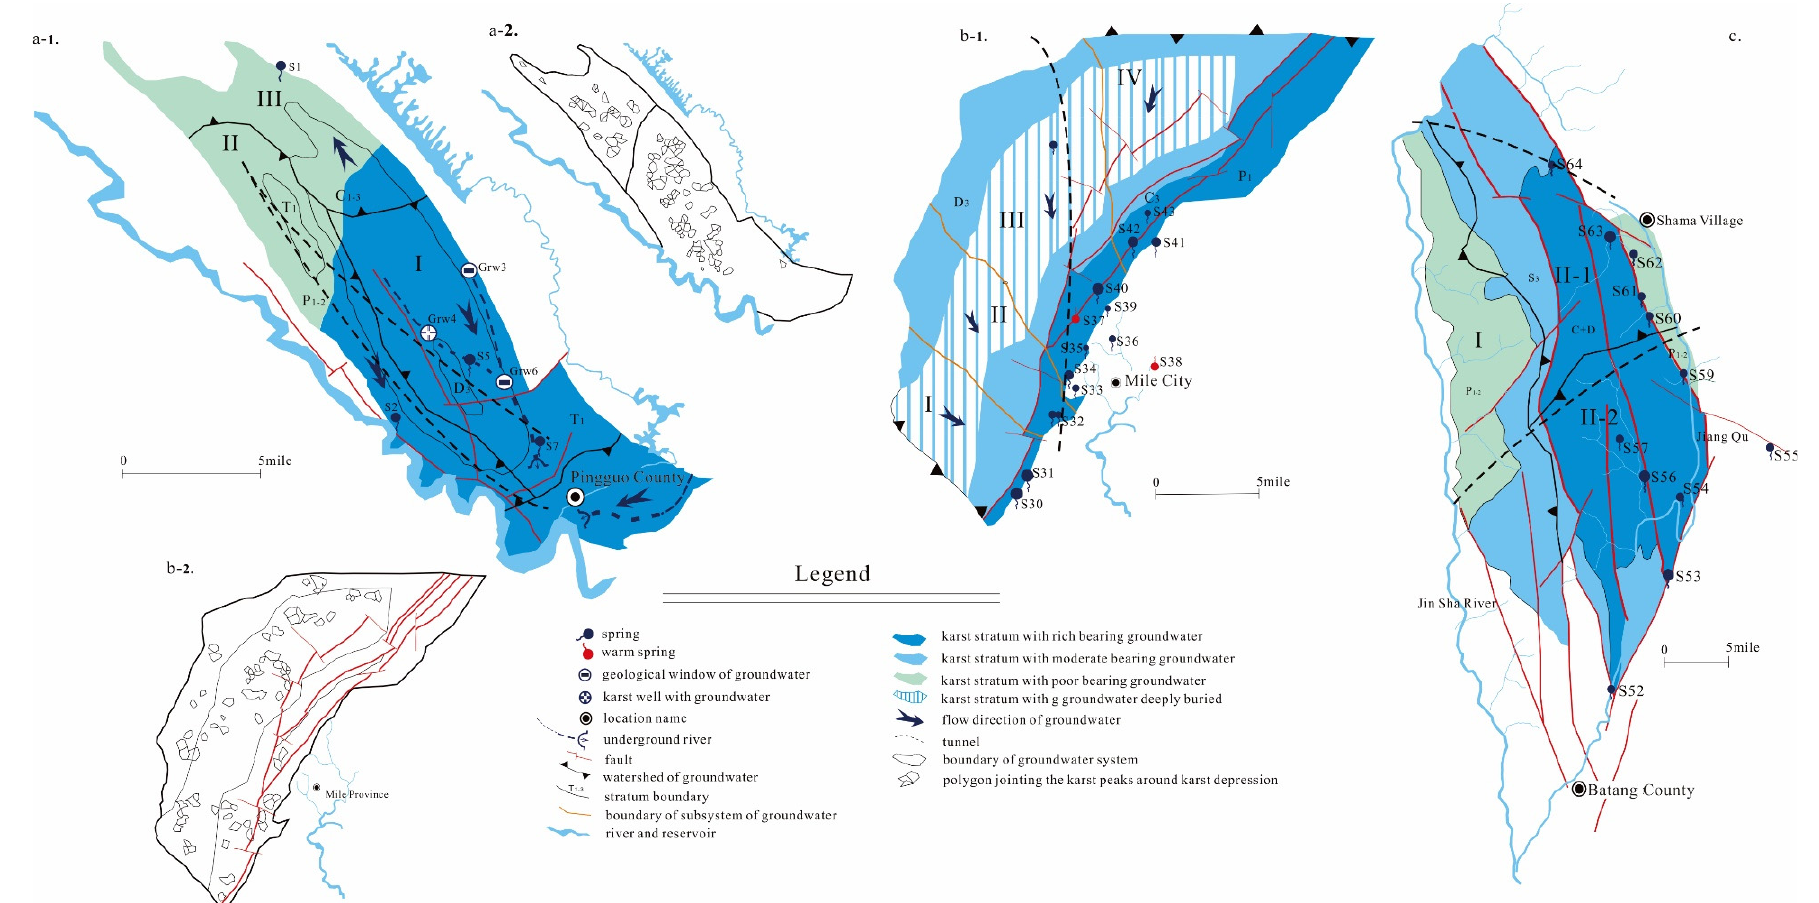
Figure 5. The typical hydrogeological system for three topography grades and tunnel layout. ( a-1 ). Layout of the Pingguo tunnel and the hydrogeology systems located in the first topography area; ( a-2 ). The polygon distribution jointing the Karst peaks around Karst depressions. ( b-1 ). Layout of the Dongfeng tunnel and the hydrogeology systems in the second topography area; ( c ). Layout of the Batang tunnel and the hydrogeologic system in the third topography area. ( a-2 , b-2 ) are used to obtain the fractal dimension representing the Karst development degree.